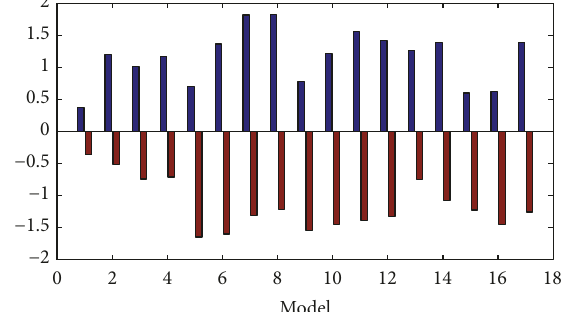
Figure 10: Average difference in predictive accuracy between a model and its generated rulesets. The lower part with negative values is obtained when rules and network